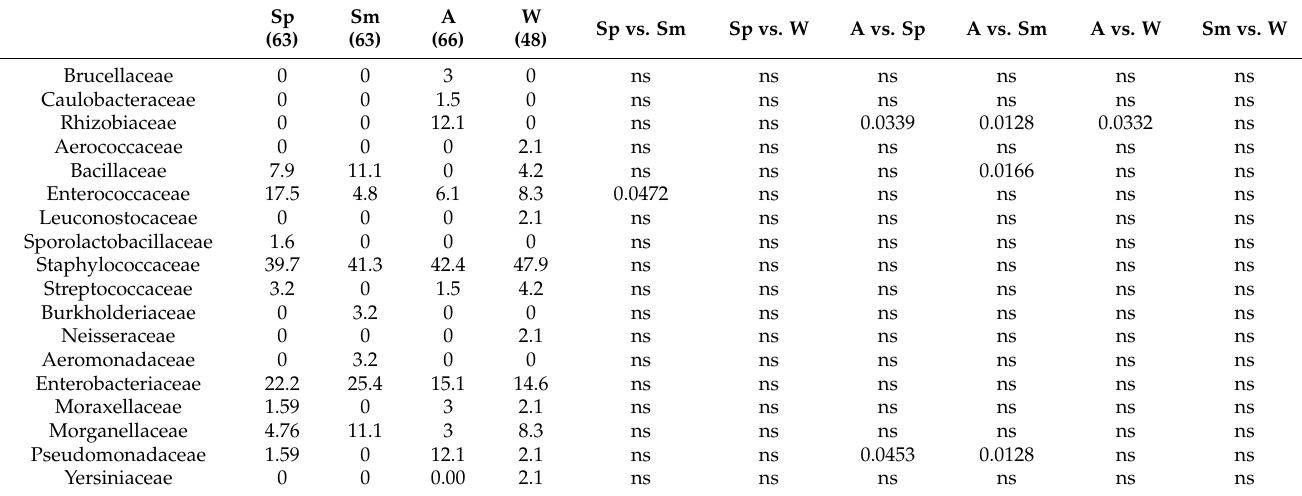
Table 5. Relative abundance (%) of cultivable bacteria at the family level according to the season of sampling. A chi-squared test was used to compare prevalence between